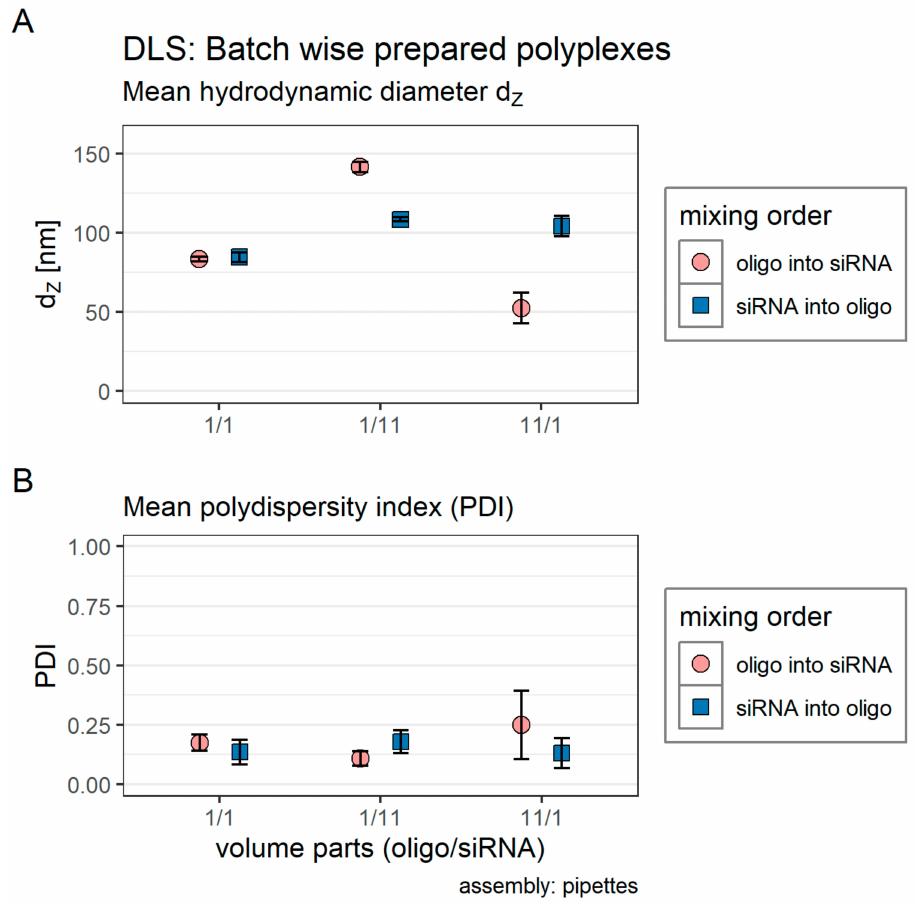
Figure 4. Influence of formulation conditions on manually prepared polyplexes (oligomer CO + siRNA). Dynamic light scattering (DLS) data are represented as the mean of three measurements. Color and shape encode the mixing order. The volume parts of both educts are denoted on the x-axis. Total volume was 70 µ L for each solution. That means, for example, that 64.2 µ L of a diluted oligomer solution (oligo) was pipetted to 5.8 µ L of a concentrated siRNA solution (light red dot, volume parts 11/1). Blue square: siRNA was pipetted into an oligomer solution. Red dot: The oligomer solution was pipetted into a siRNA solution. ( A ) Mean hydrodynamic diameter (z-average). ( B ) Mean polydispersity index (PDI). Statistics: Error bars correspond to 95% confidence intervals. N =